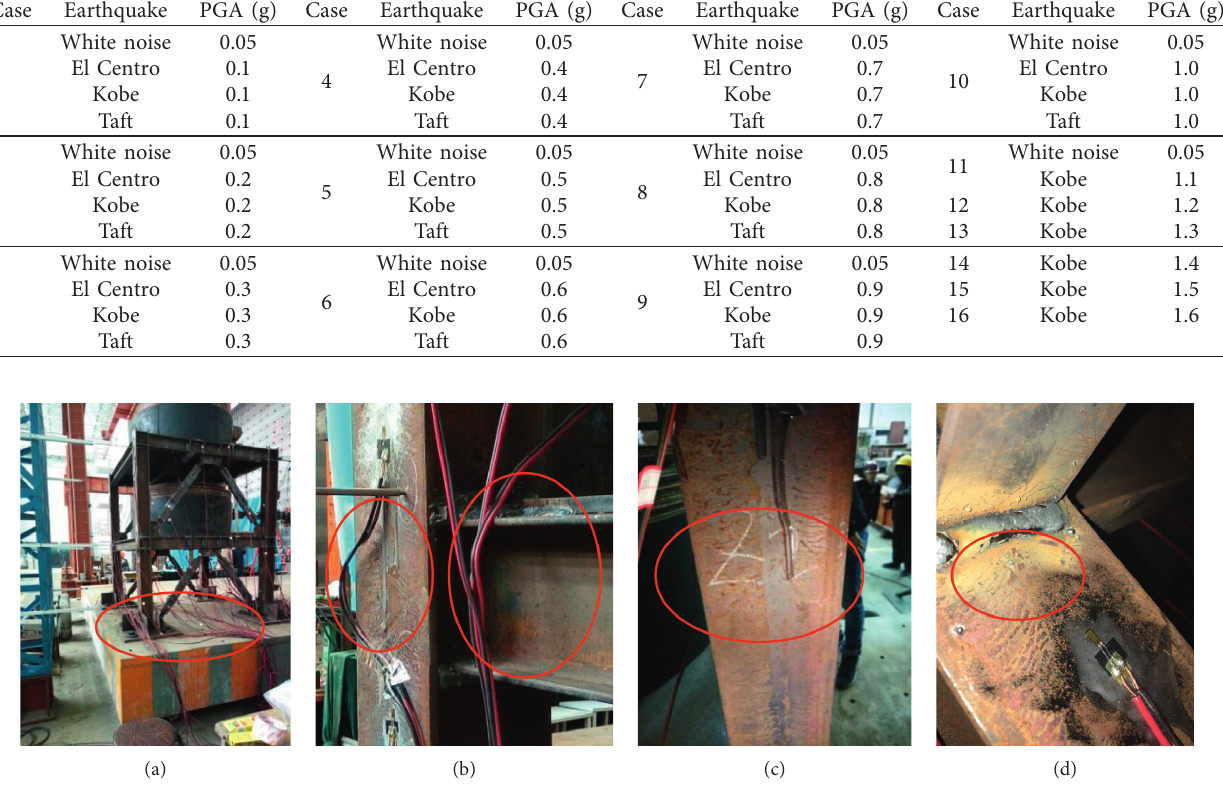
Figure 13: Test phenomena. (a) Scattered dust. (b) Dropped rust spots. (c) Tension texture. (d) Crack of